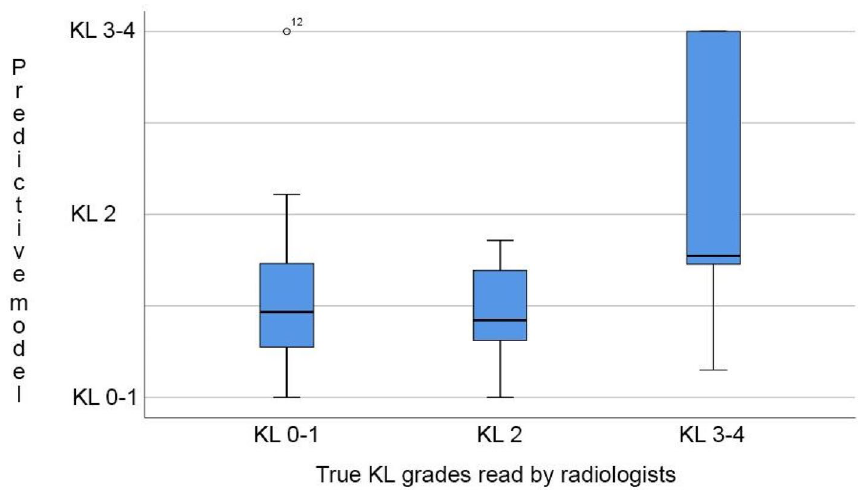
Figure 4. The boxplot describing the predicted KL grades (Y-axis) according to the predictive model within the radiologic KL grades (X-axis) in male